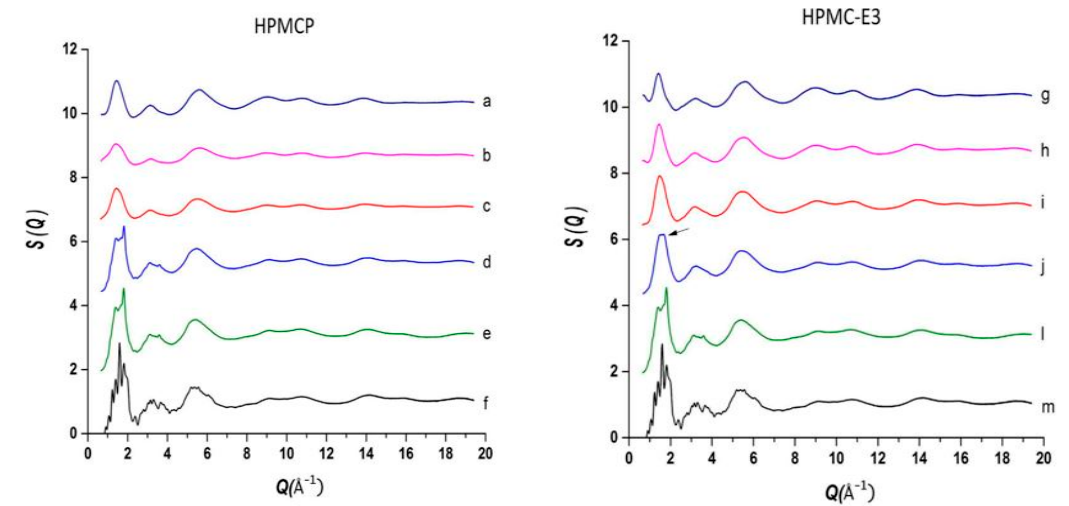
Figure 12. Comparison of the measurement of total scattering structure factors for spray dried (SD) lapatinib (LP) free- base, polymers and their mixtures: ( a ) pure hypromellose phthalate (HPMCP) (SD); ( b ) 1:3 LP:HPMCP; ( c ) 1:1 LP:HPMCP; ( d ) 3:1 LP:HPMCP; ( e , l ) pure amorphous LP (SD); ( f , m ) crystalline lapatinib raw material (as is, not spray dried); ( g ) pure Hypromellose (HPMC-E3) spray dried; ( h ) 1:3 LP:HPMC-E3; ( i ) 1:1 LP:HPMC-E3; ( j ) 3:1 LP:HPMC-E3, arrow indicates residual crystallinity that was detected. The figure was taken from de Araujo, G.L., C.J. Benmore, and S.R. Byrn, Local Structure of Ion Pair Interaction in Lapatinib Amorphous Dispersions characterized by Synchrotron X-Ray diffraction and Pair Distribution Function Analysis. Scientific Reports, 2017. 7: p. 46367. Copyright (2017), with permission from Springer Nature [113] .